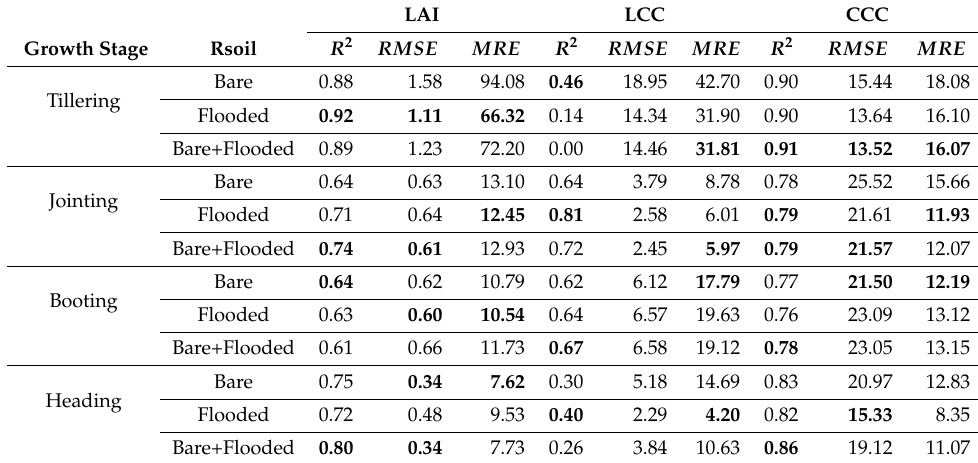
Table 3. Growth-stage-specific goodness-of-fit of results of Figure